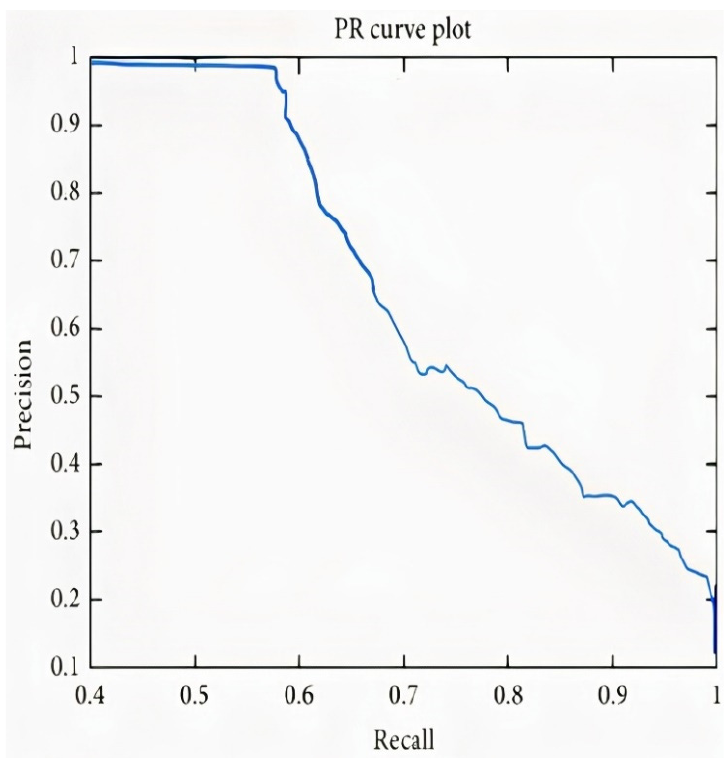
Figure 18. PR curve of Arousal Figure 18. Figure 2 PR curve of Arousal label. Figure 18. Figure 2 PR curve of Arousal label.